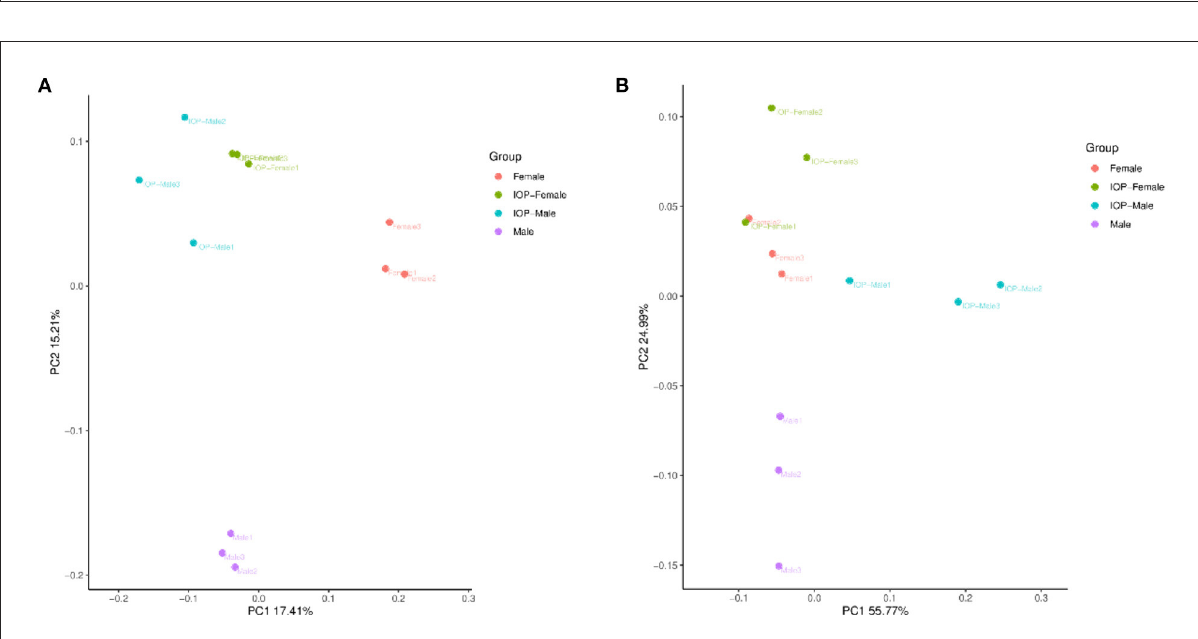
(3.28%), Campilobacterota (1.1%), Spirochaetota (1.6%), Proteobacteria (1.1%) and Actinobacteriota (0.2%) were some of the additional phyla that were also detected. At the genus (22.3%), Prevotella (12.2%), Lachnospiraceae_NK4A136_group